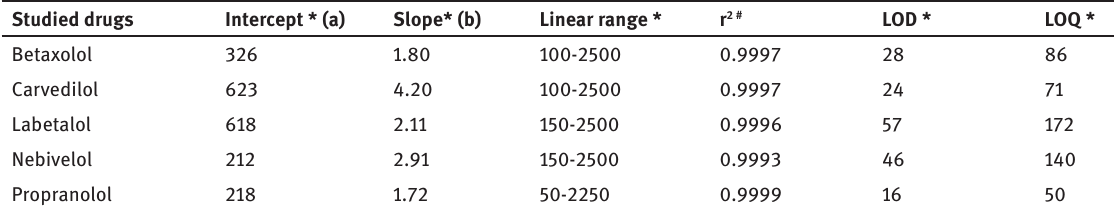
Table 2: Summary of quantitative parameters and statistical data of the proposed method. Studied